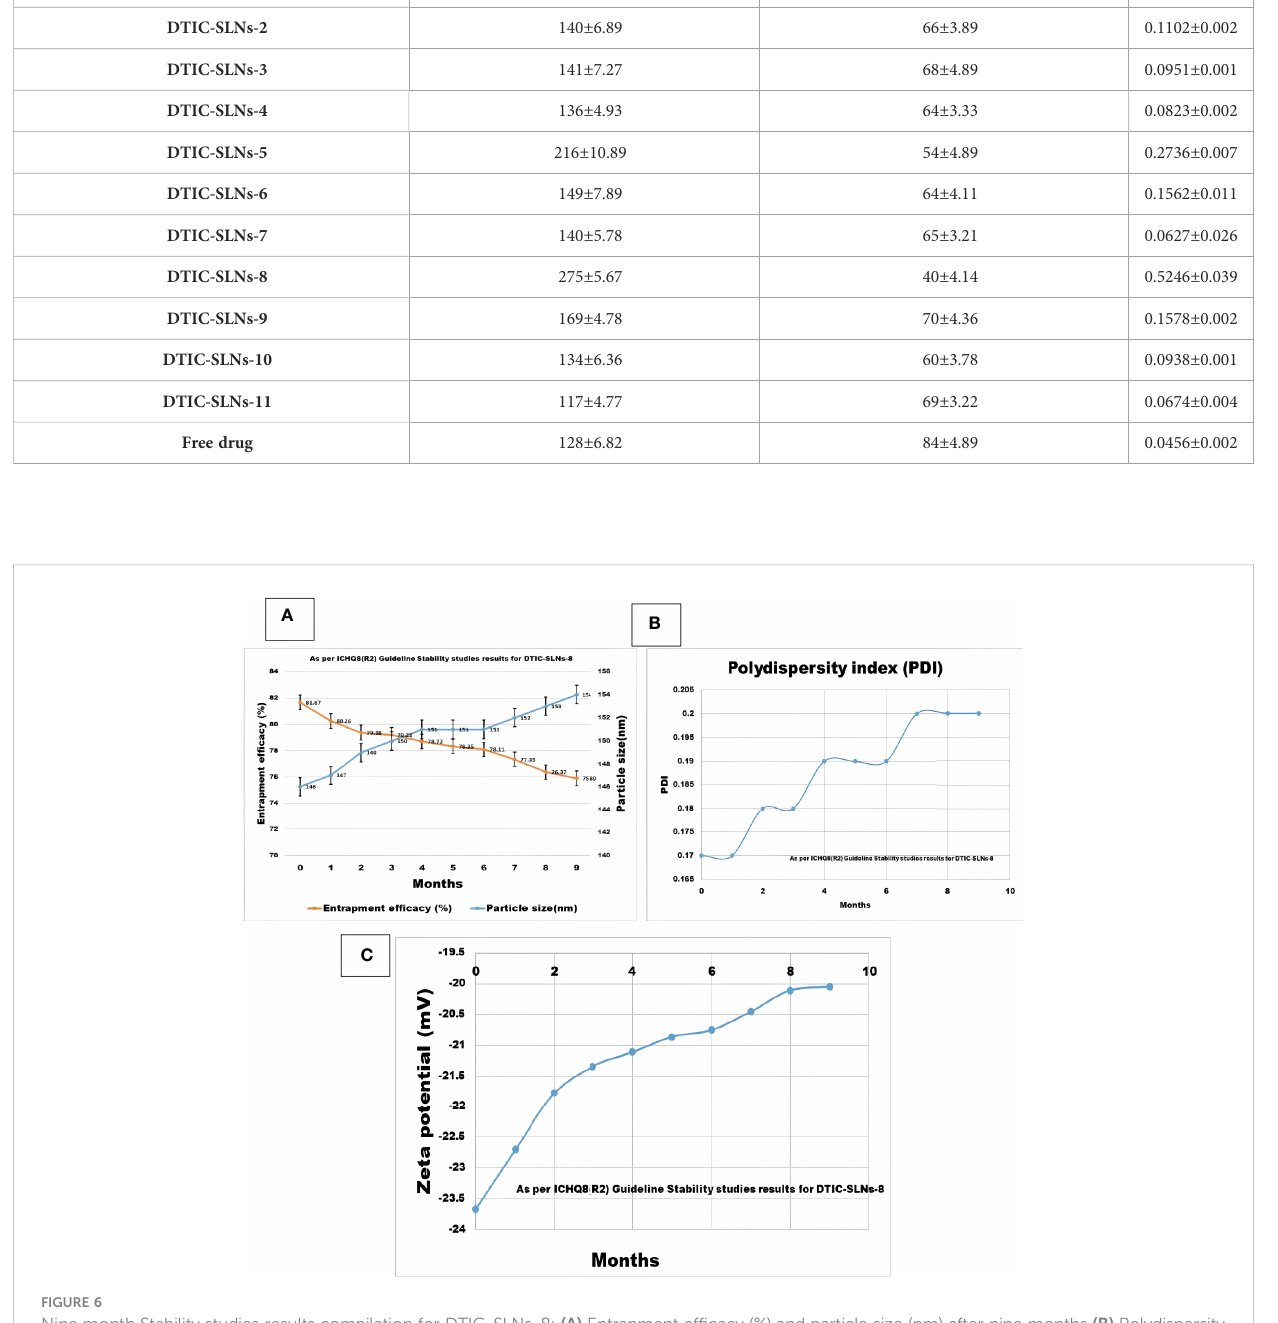
FIGURE 6 Nine month Stability studies results compilation for DTIC-SLNs-8; (A) Entrapment ef fi cacy (%) and particle size (nm) after nine months (B) Polydispersity index (PI) after nine months (C) Zeta potential (mV) after nine months.